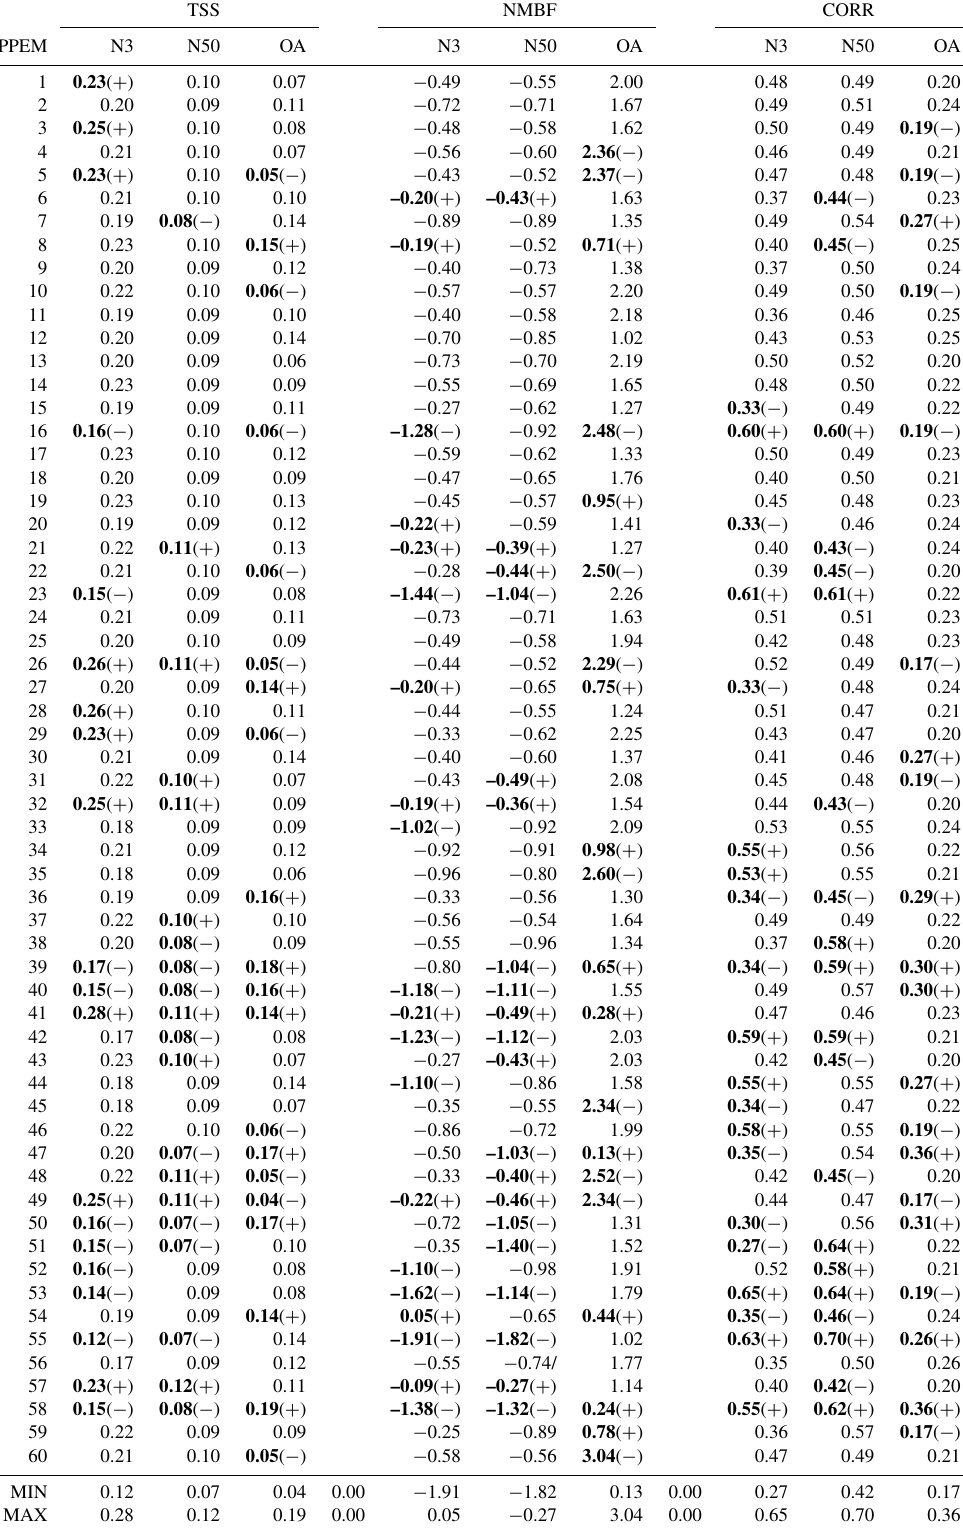
Table A1. Summary statistics – Taylor skill score (TSS), normalized mean bias factor (NMBF), and Pearson correlation coefficient ( R ) – for each ensemble member, based on model comparison against observations of N3, N50, and OA. The 10 best and 10 worst simulations in each category are highlighted in bold and designated with ( + ) and ( − )